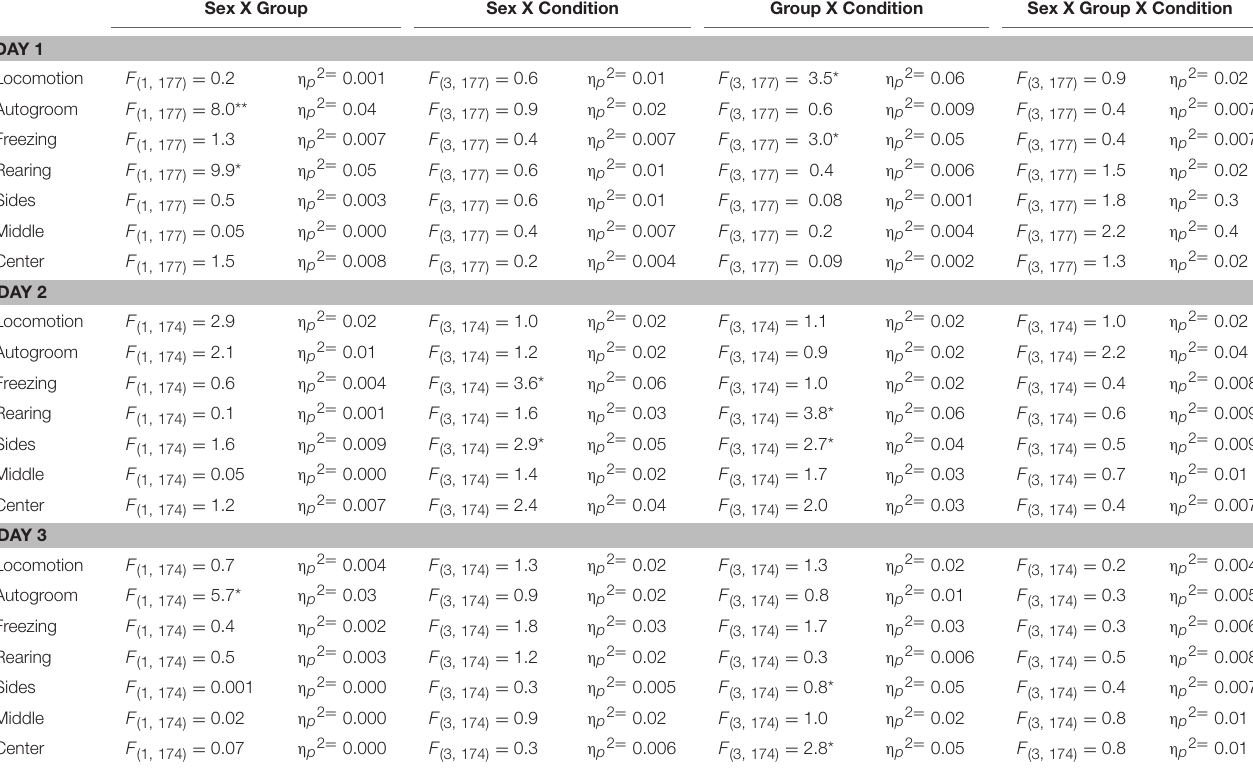
TABLE 2 | ANOVA results for the interaction